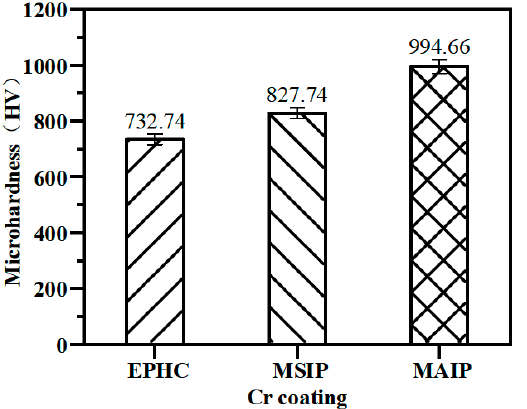
Figure 5. Mean mircohardness measured on the top surface of chromium coatings (working load 10 g, holding load 10 s).